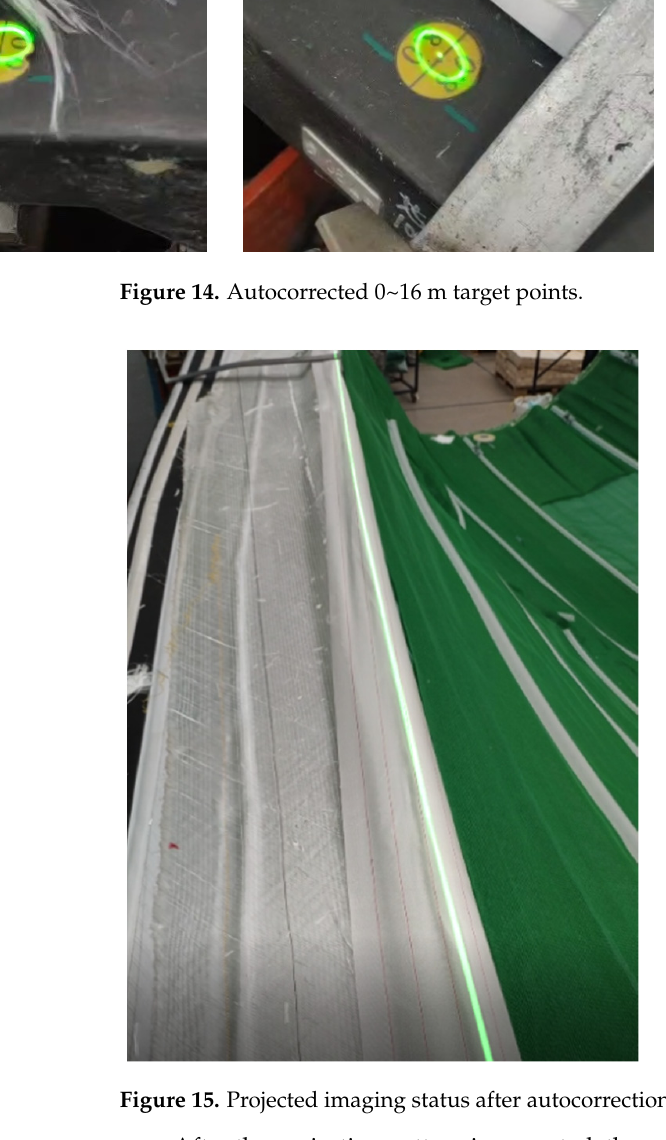
Figure 15. Projected imaging status after autocorrection.